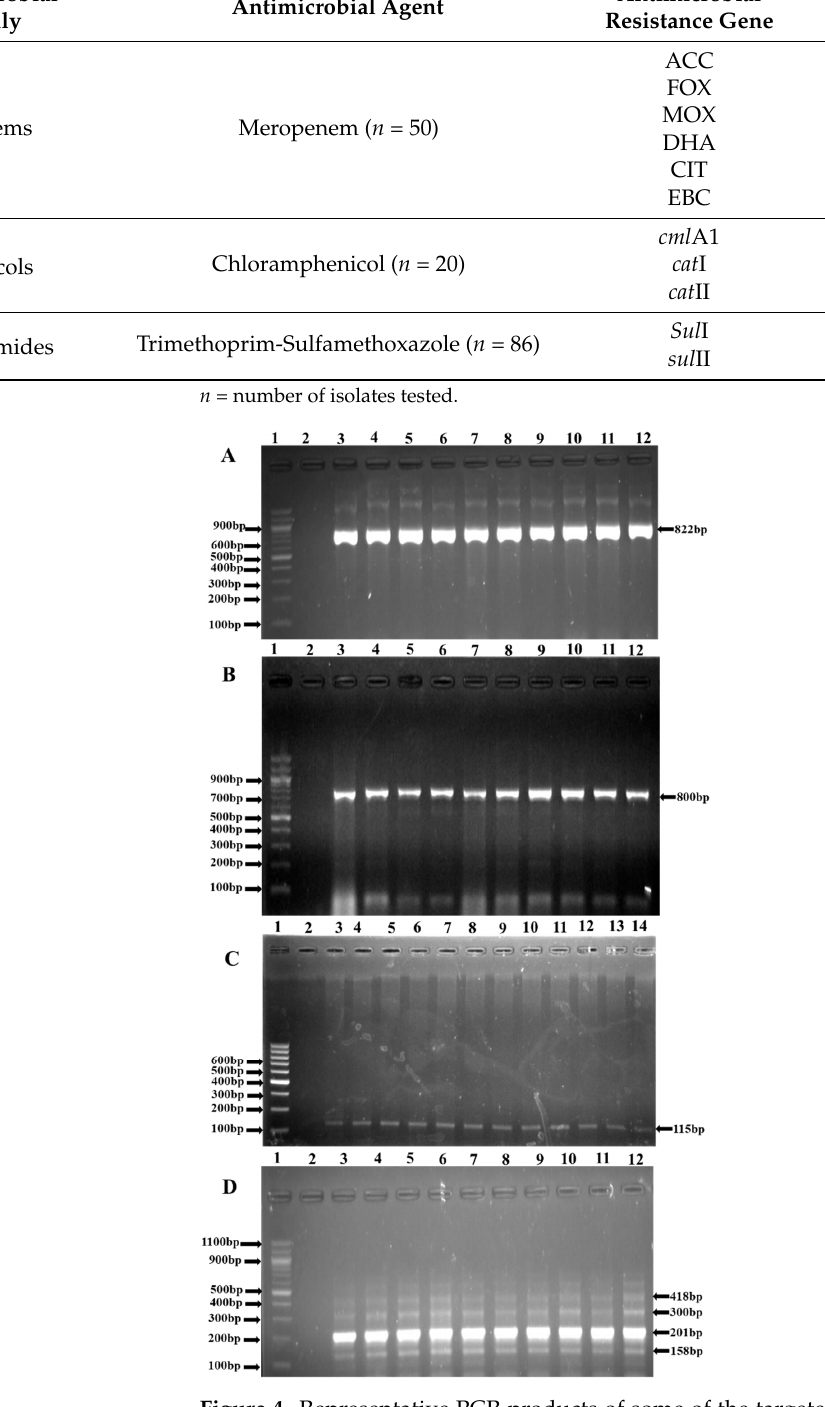
Figure 4. Representative PCR products of some of the targeted resistance genes. ( A ): Gel picture showing sul I resistance gene (822 bp). Lane 1: Molecular weight Marker (100 bp); Lane 2: Negative control; Lanes 3–12: positive isolates. ( B ): Gel picture showing bla TEM resistance gene (800 bp). Lane 1: Molecular weight Marker (100 bp); Lane 2: Negative control; Lanes 3–12: positive isolates. ( C ): Gel picture showing cml A1 resistance gene (115 bp). Lane 1: Molecular weight Marker (100 bp); Lane 2: Negative control; Lanes 3–14: positive isolates. ( D ) Multiplex PCR products for the amplification of tet A (201 bp), tet C (418 bp), tet D (300 bp), and tet M (158 bp). Lane 1: Molecular weight Marker (100 bp); Lane 2: Negative control; Lanes 3–12: positive isolate.